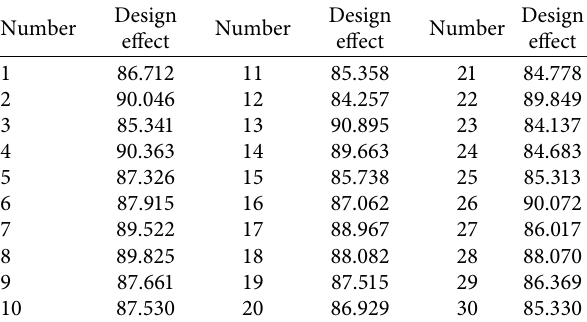
Table 2: Design effects of fractal art